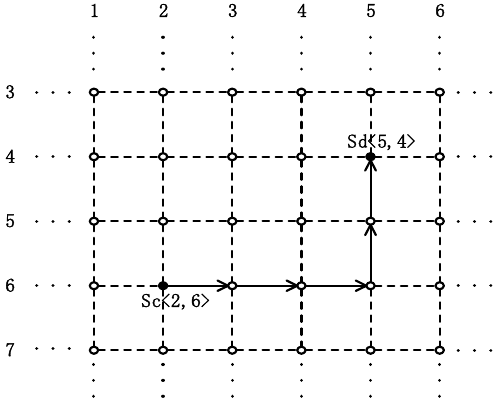
Figure 3. Main path calculation.